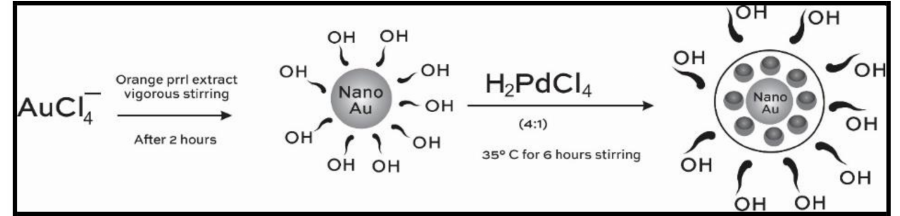
Figure 5. Representation of an hydroxyl group associated Au-Pd core.